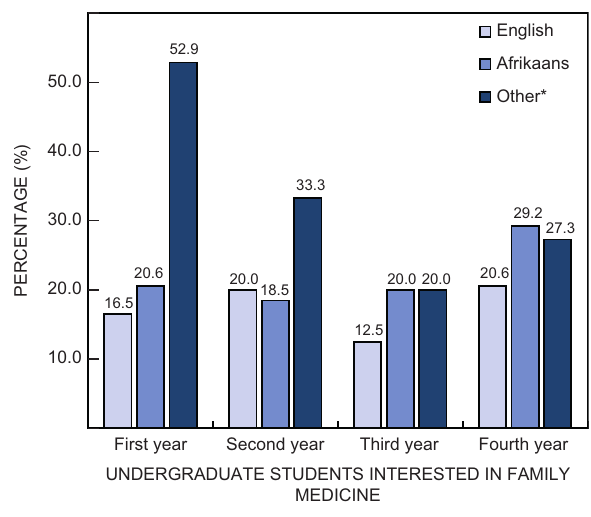
Figure 1: Percentage of undergraduate students who are interested in specialising in Family Medicine, according to gender and year of study.